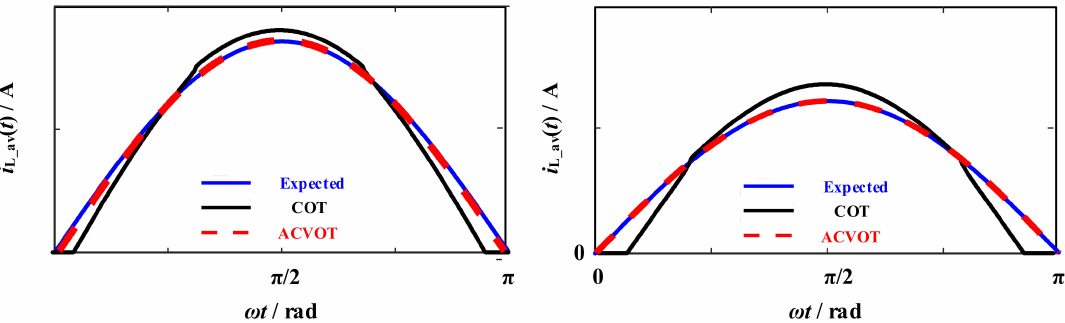
Figure 8. The simulated input current waveforms with full load under the COT control and the ACVOT